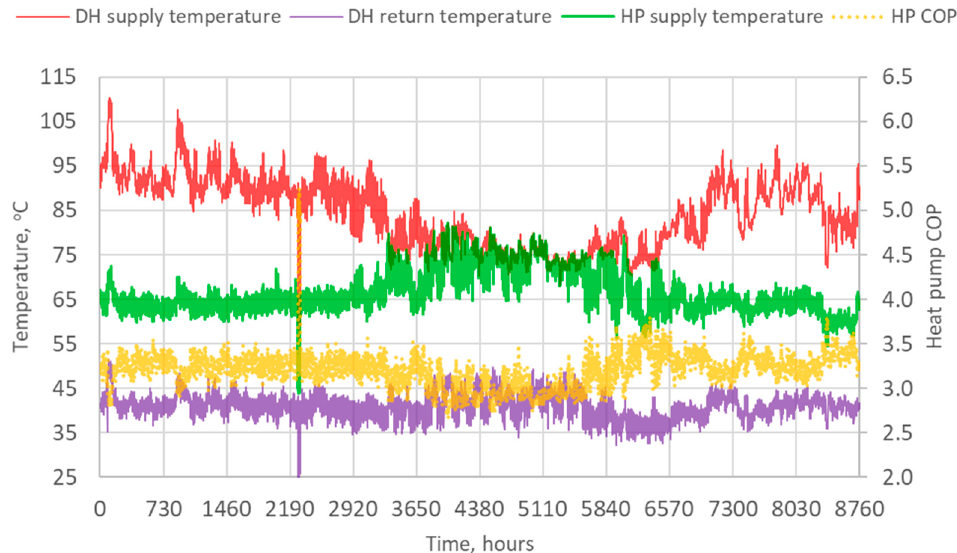
Figure 6. Annual evolution of DH–GSHP network temperatures in scenario 2.